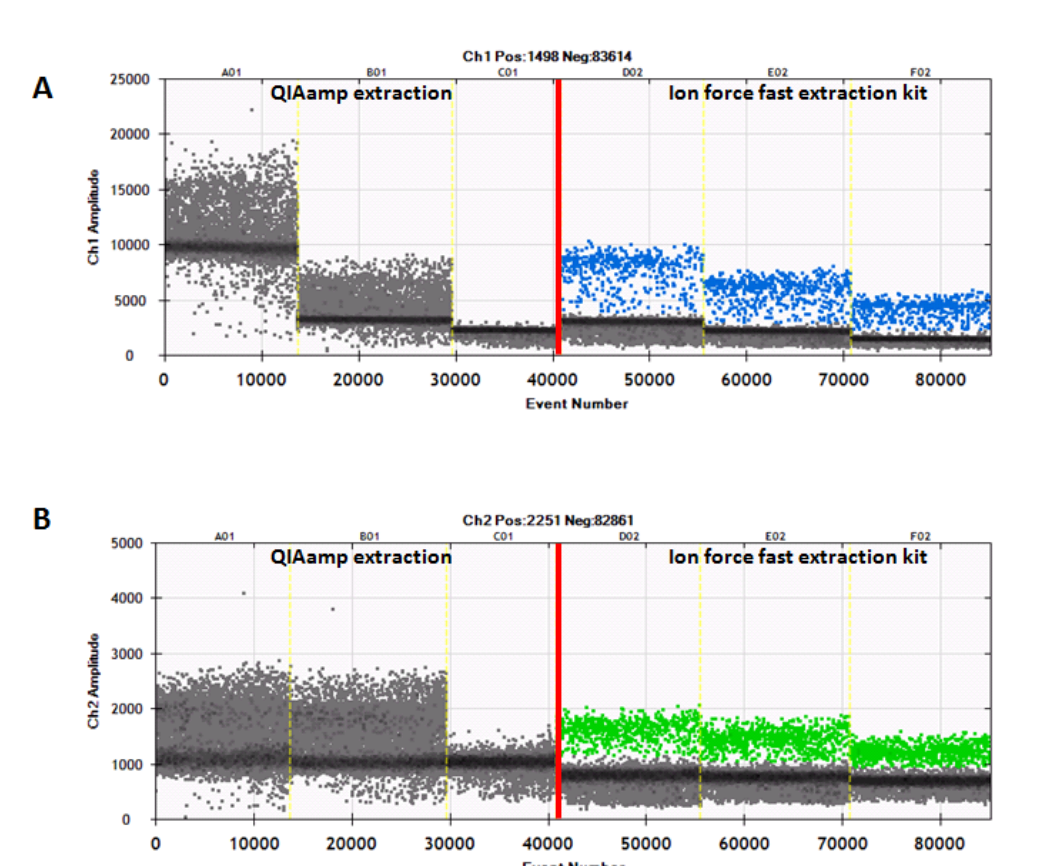
Figure 2. The ddPCR of representative samples extracted by the QIAamp mini kit or the Ion Force Fast kit. ( A ) The detection of bovine DNA is indicated by blue droplets. ( B ) The detection of buffalo DNA is indicated by green droplets.